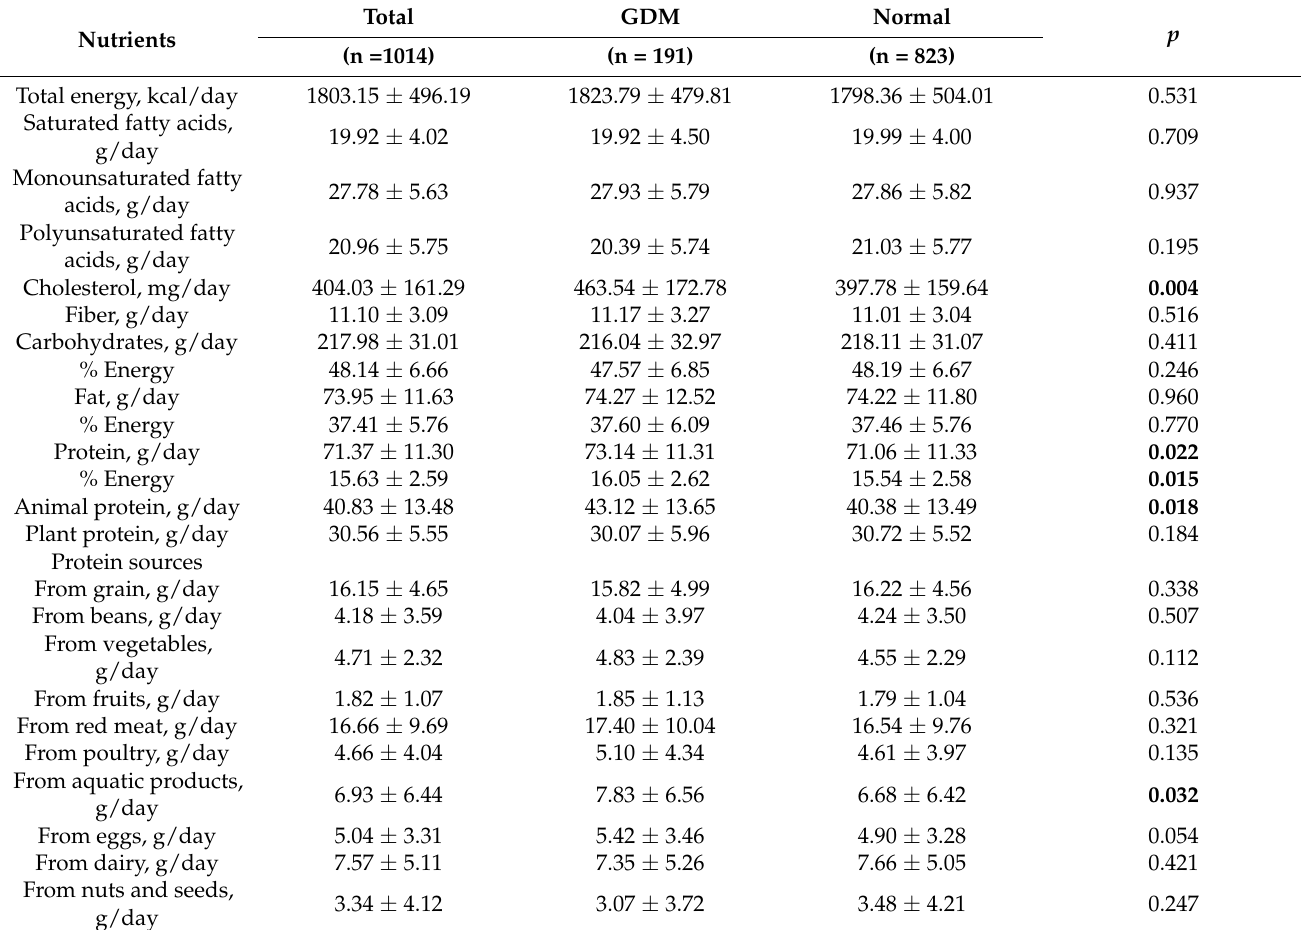
Table 2. Daily nutrient consumption of pregnant women by categories of GDM.